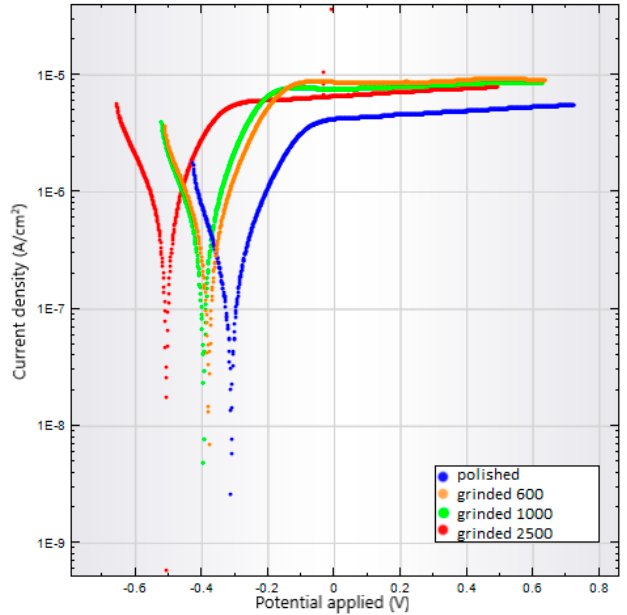
Figure 9. Polarization curves for the Ti6Al4V surfaces polished or ground on 600 to 2500 Grit.